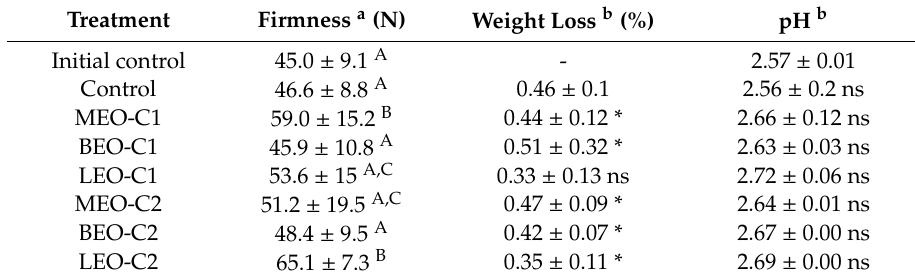
Table 4. E ff ects of essential oils of mint (MEO), basil (BEO), and lavender (LEO) acting as vapor on firmness (N), weight loss (%), and pH recorded in lemon fruits after storage for 7 days.